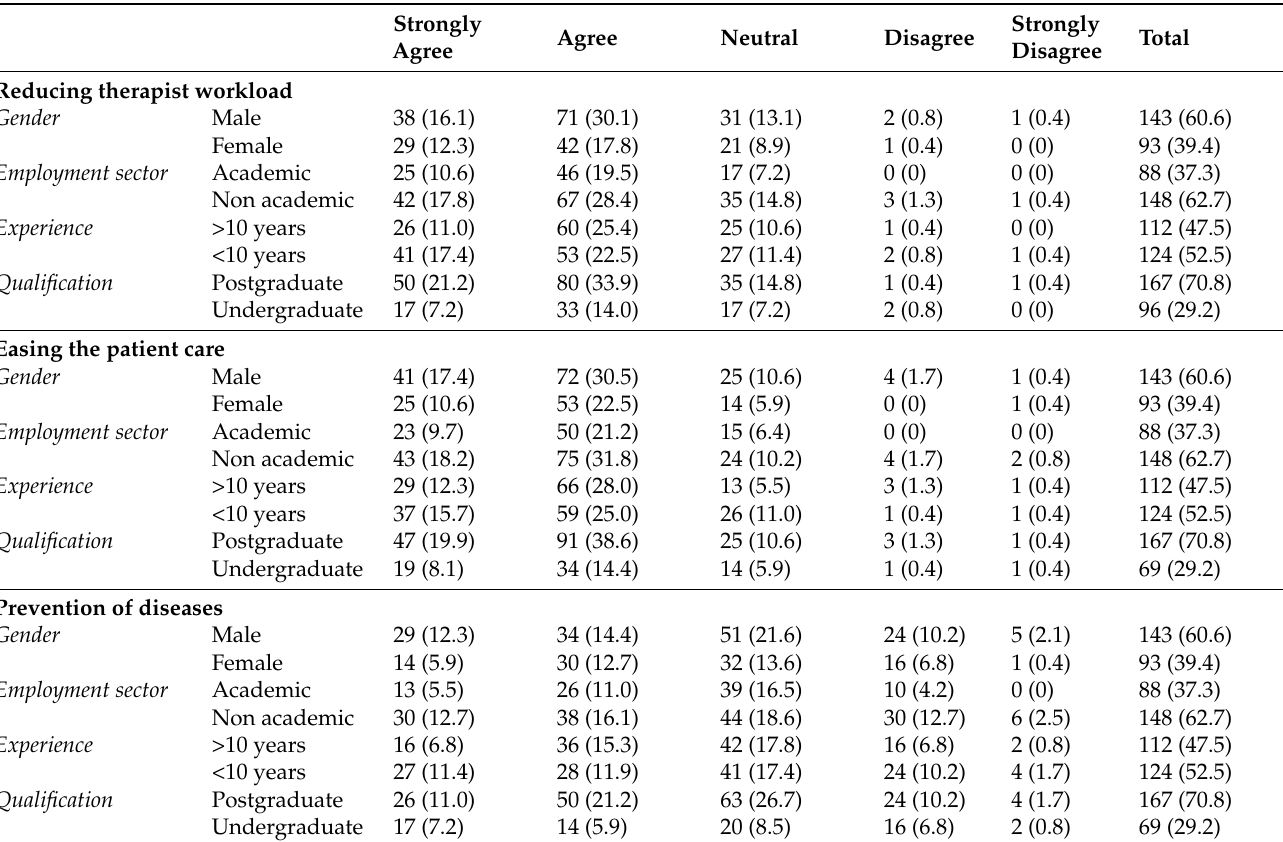
Table 4. Participant’s attitudes on AI advantages in clinical